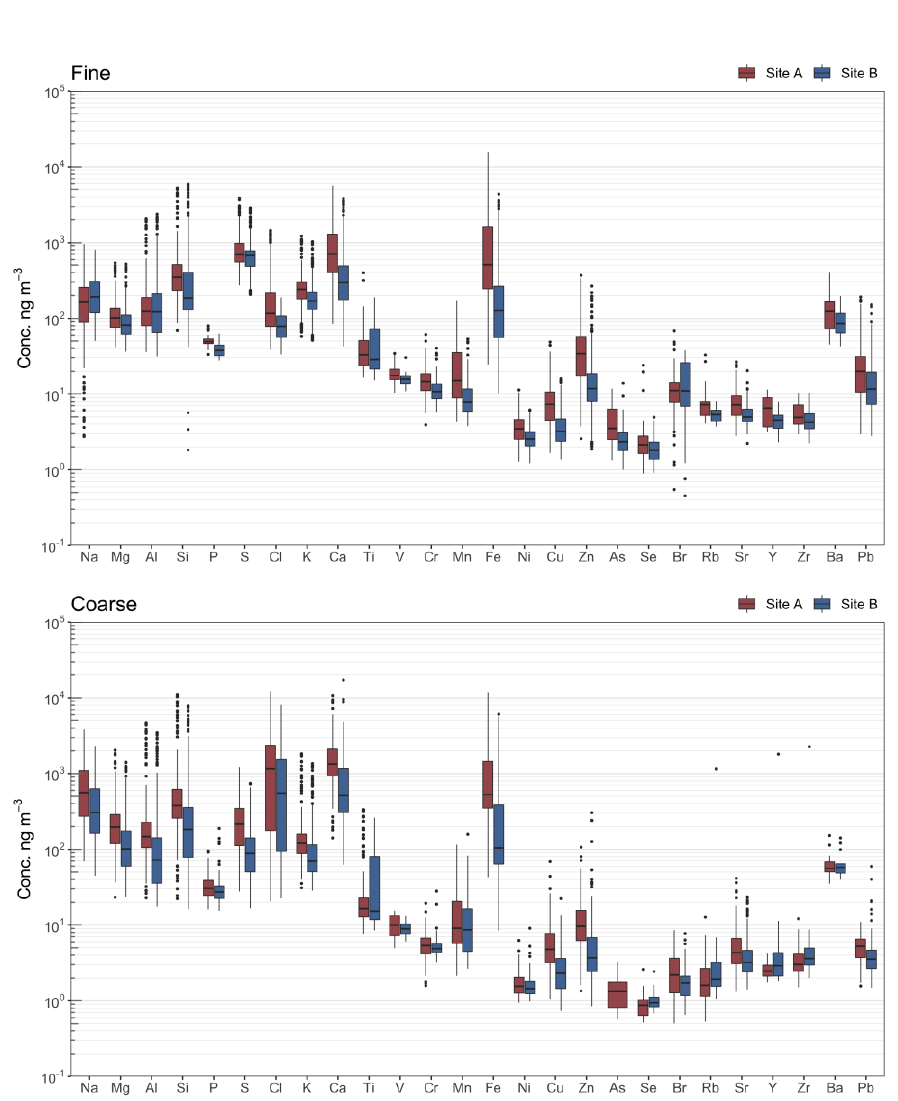
Figure 2. Box and whisker plot of the elemental concentrations in two sampling sites for the fine (upper) and the coarse (lower) fractions. Boxes indicate the inter-quartile range, black horizontal lines are average values and the ends of the whiskers represent the 10th and 90th percentiles.